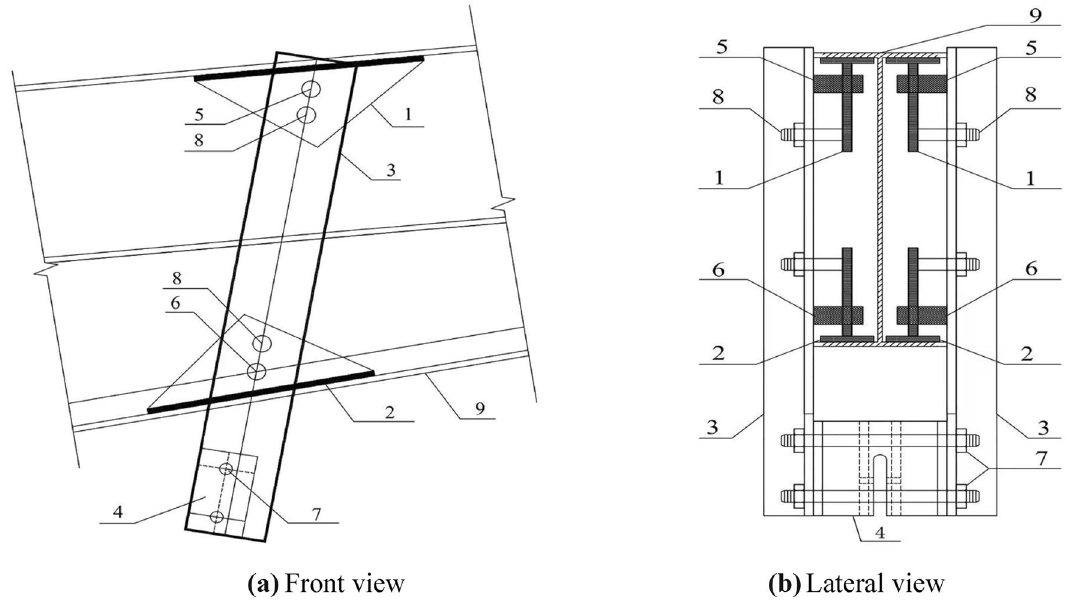
Fig.4 1-shaped anchoring joint: 1 upper triangle friction component, 2 lower triangle friction component, 3 1 type component; 4 anchoring component, 5 upper fixed rod, 6 lower fixed rod, 7, bolt rod, 8 adjusting rod, 9 steel